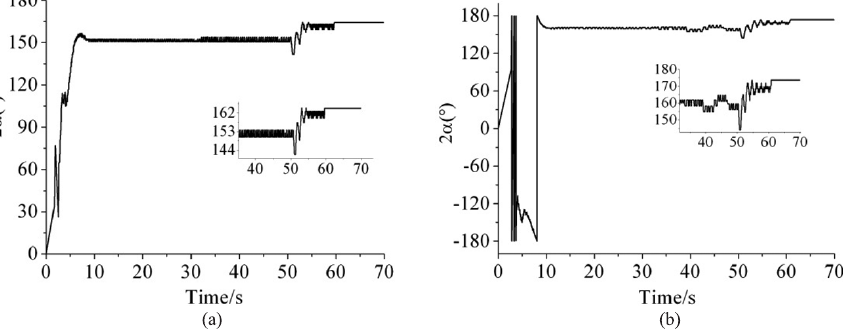
Fig. 10. The experimental results of phase difference of the two exciters rotating in the same directions for different η ( 2 α = ϕ 1 − ϕ 2 ) : (a) η = 1 . 0 ; (b) η = 0 . 8 . the motor 2 is cut off, the phase difference decreases from 145 ◦ to 132 . 9 ◦ and the synchronous rotational velocity increases to 795.5 r/min, as shown in Figs 8(a) and (b). But the synchronization of the two exciters continues, this